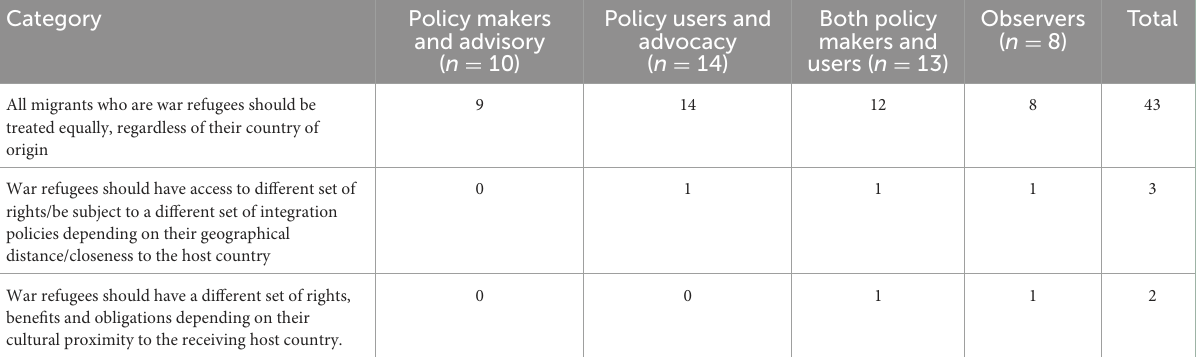
TABLE 1 Stakeholders on the treatment of various groups of migrants ∗ .